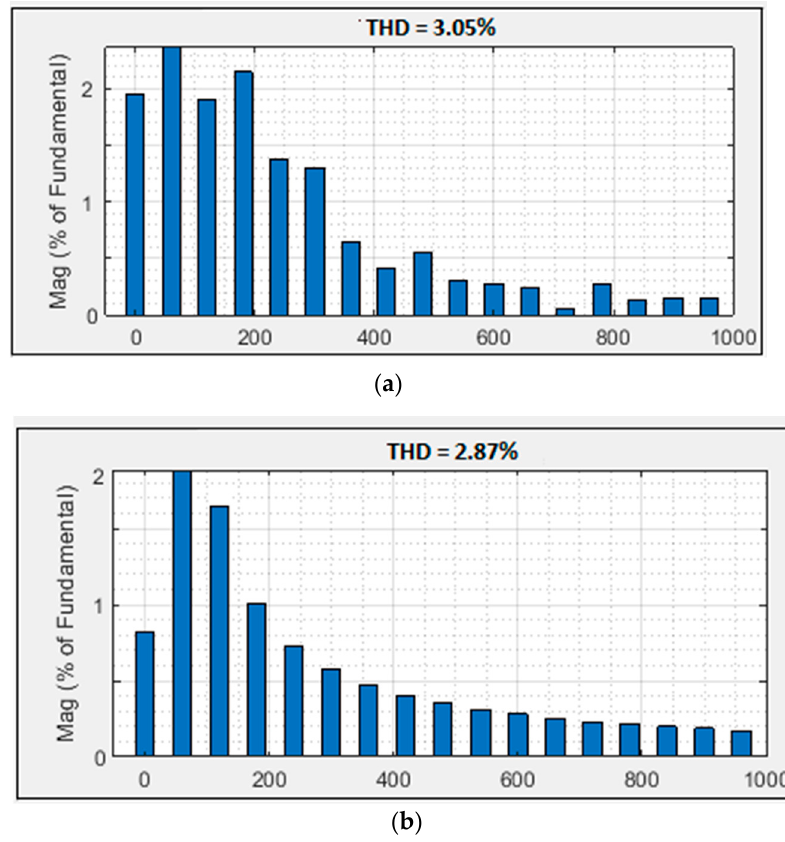
Figure 11. Current harmonics at PCC ( a ) Hybrid with MC, ( b ) Hybrid with MC and SVC.